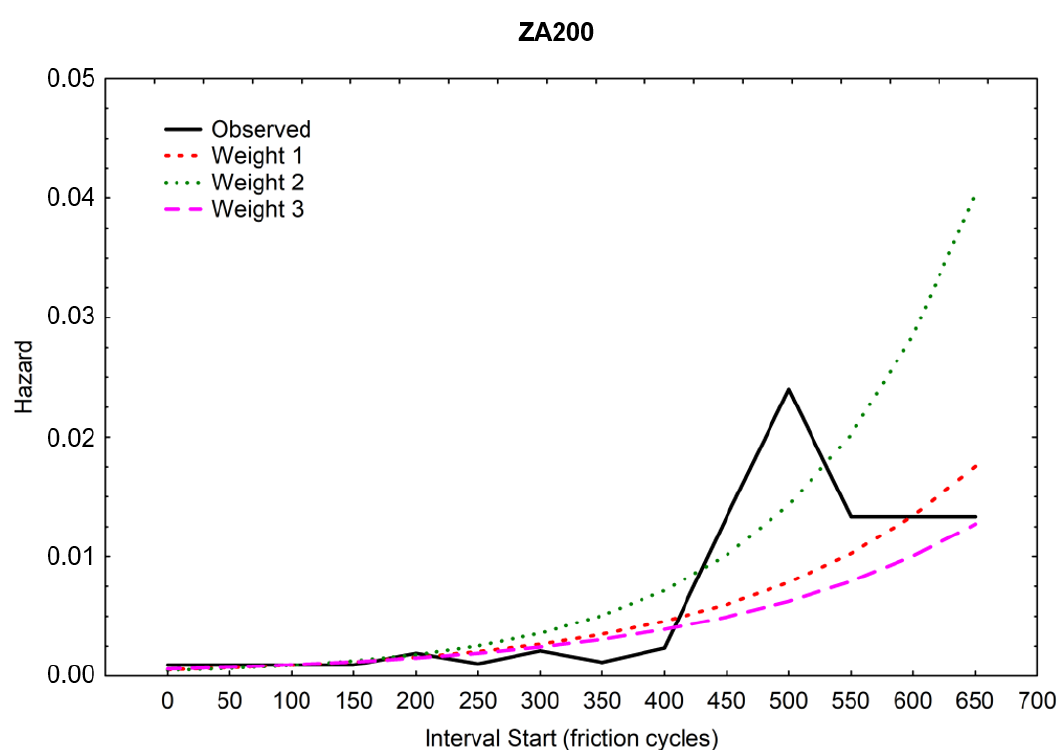
Figure 17. Hazard function for the ZA200 sheet metal (“black”).